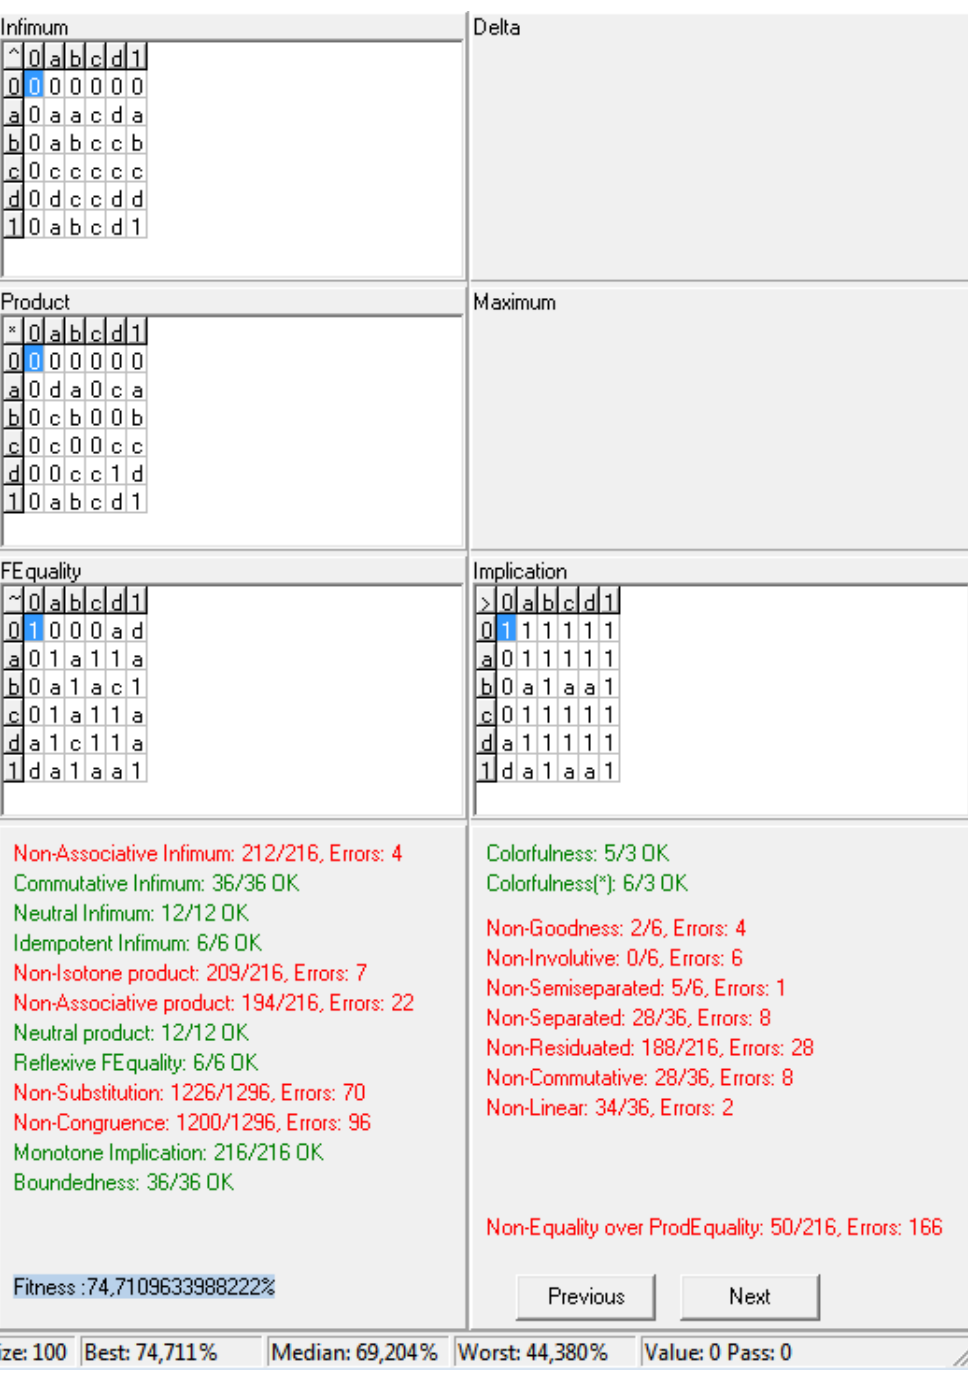
Figure 5. EQCreator and properties of an